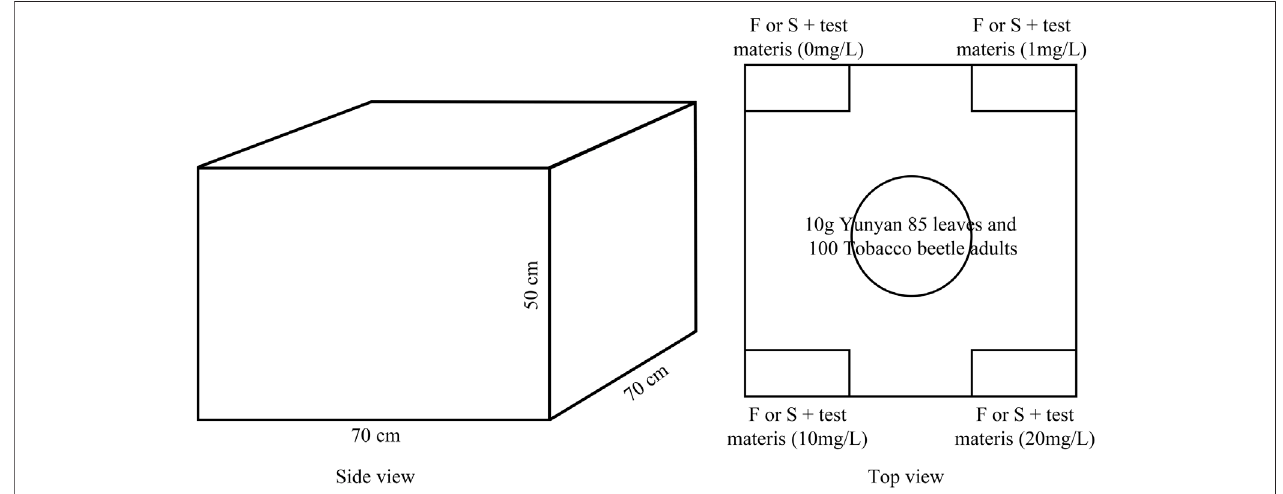
FIGURE 2 | The diagram for the laboratory simulation test on tobacco beetle adults.